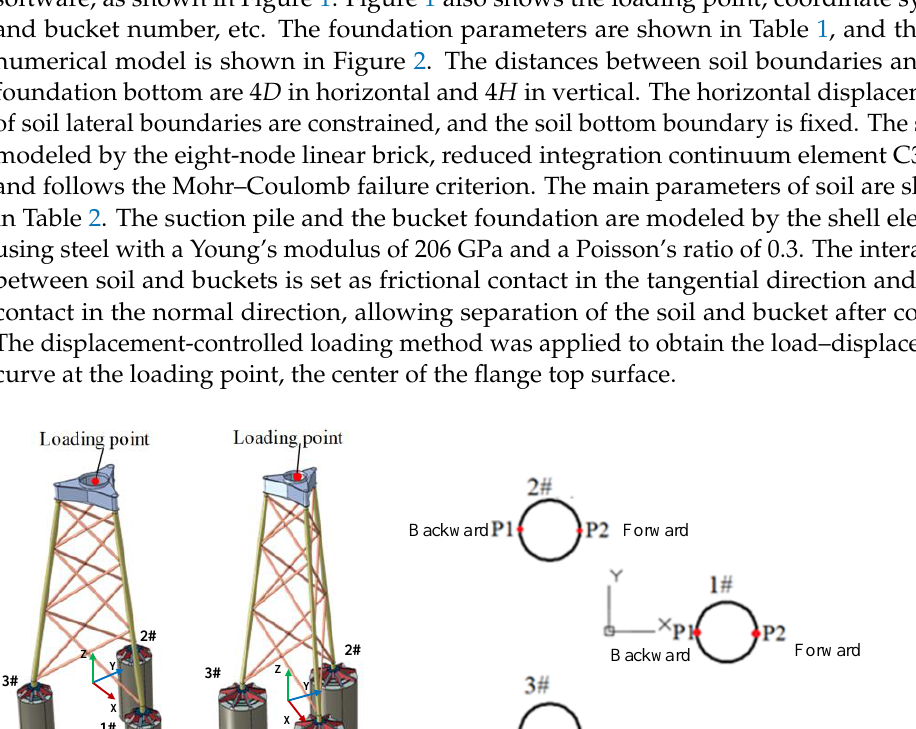
Figure 2. Soil numerical model. 2. Comparison of Bearing Characteristics of the TSPJF and TBJF under Vertical Load Figure 3 shows the vertical load – displacement curves of the TSPJF and TBJF. Since both load – displacement curves have obvious inflection points, the loads corresponding to the inflection points can be regarded as the ultimate bearing capacity. The vertical bear- ing capacities of TSPJF and TBJF are 197.94 MN and 193.80 MN, respectively, and the cor- responding vertical displacements are 0.72 m and 0.46 m, respectively. The difference be- tween the ultimate bearing capacity of the TSPJF and TBJF is very small, but the corre- sponding vertical displacement of TBJF is significantly smaller than that of TSPJF. Figure 4 shows soil equivalent plastic strain contours at the 2# and 3# bucket central section for TSPJF and TBJF under the ultimate vertical load. As shown in the figure, the maximum equivalent plastic strain of soil appears at the bucket end for TSPJF, and the plastic failure develops along the depth direction, eventually forming an asymmetrical “ V-shaped ” plastic failure zone. Similar to the failure mode of TSPJF, the maximum equiv- alent plastic strain of soil also appears at the bucket end of TBJF and expands along the depth. However , the soil at the end of the bucket of TBJF does not form a continuous “V - shaped” plastic failure zone under the ultimate vertical load.